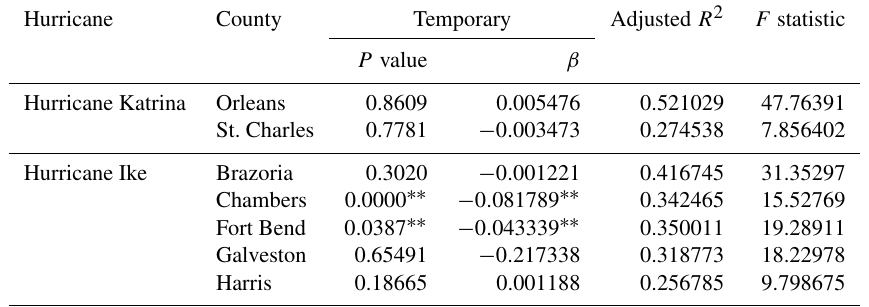
Table 3. Results of temporary impact for employment. Statistical significance at the 5% level is indicated by a double asterisk ( ∗∗ ) Hurricane County